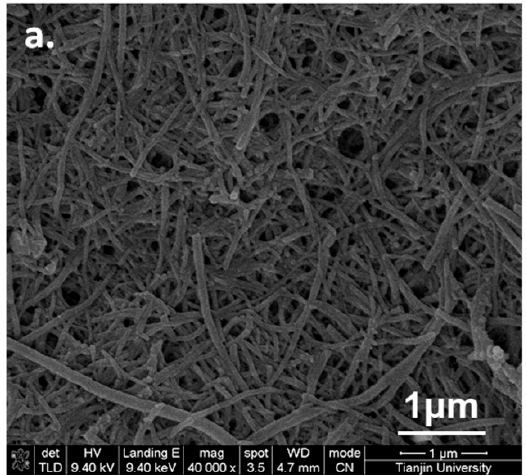
Figure 2. SEM images of PANI obtained by electropolymerization in fresh electrolyte solution [32].